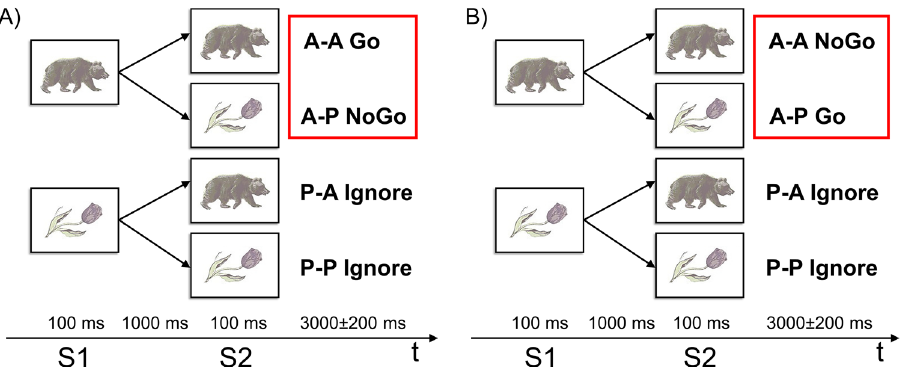
Figure 2. Experimental design of the Go/NoGo task. S1—first stimulus (preparatory cue). S2—second stimulus (imperative stimulus). A—images of animals, P—images of plants. ( A ) First experiment: “A-A Go”, “A-P NoGo”. ( B ) Second experiment: “A-P Go”, “A-A NoGo”. Red boxes highlight trials that were compared to test the hypothesis of selective and non-selective response